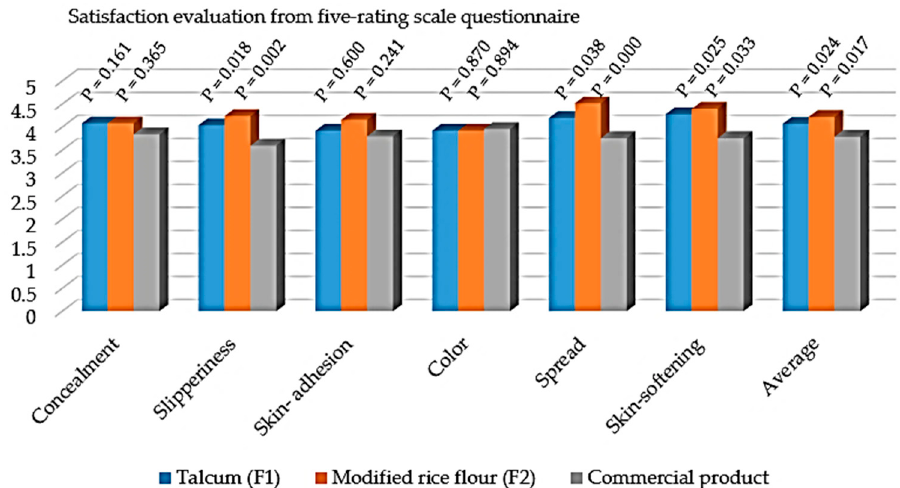
Figure 7. Bar graph of satisfaction with each powder: talcum compact powder (F1), modified rice flour replaced talcum (F2), and a commercial product; p -value from the paired samples t -test compared to the commercial product.